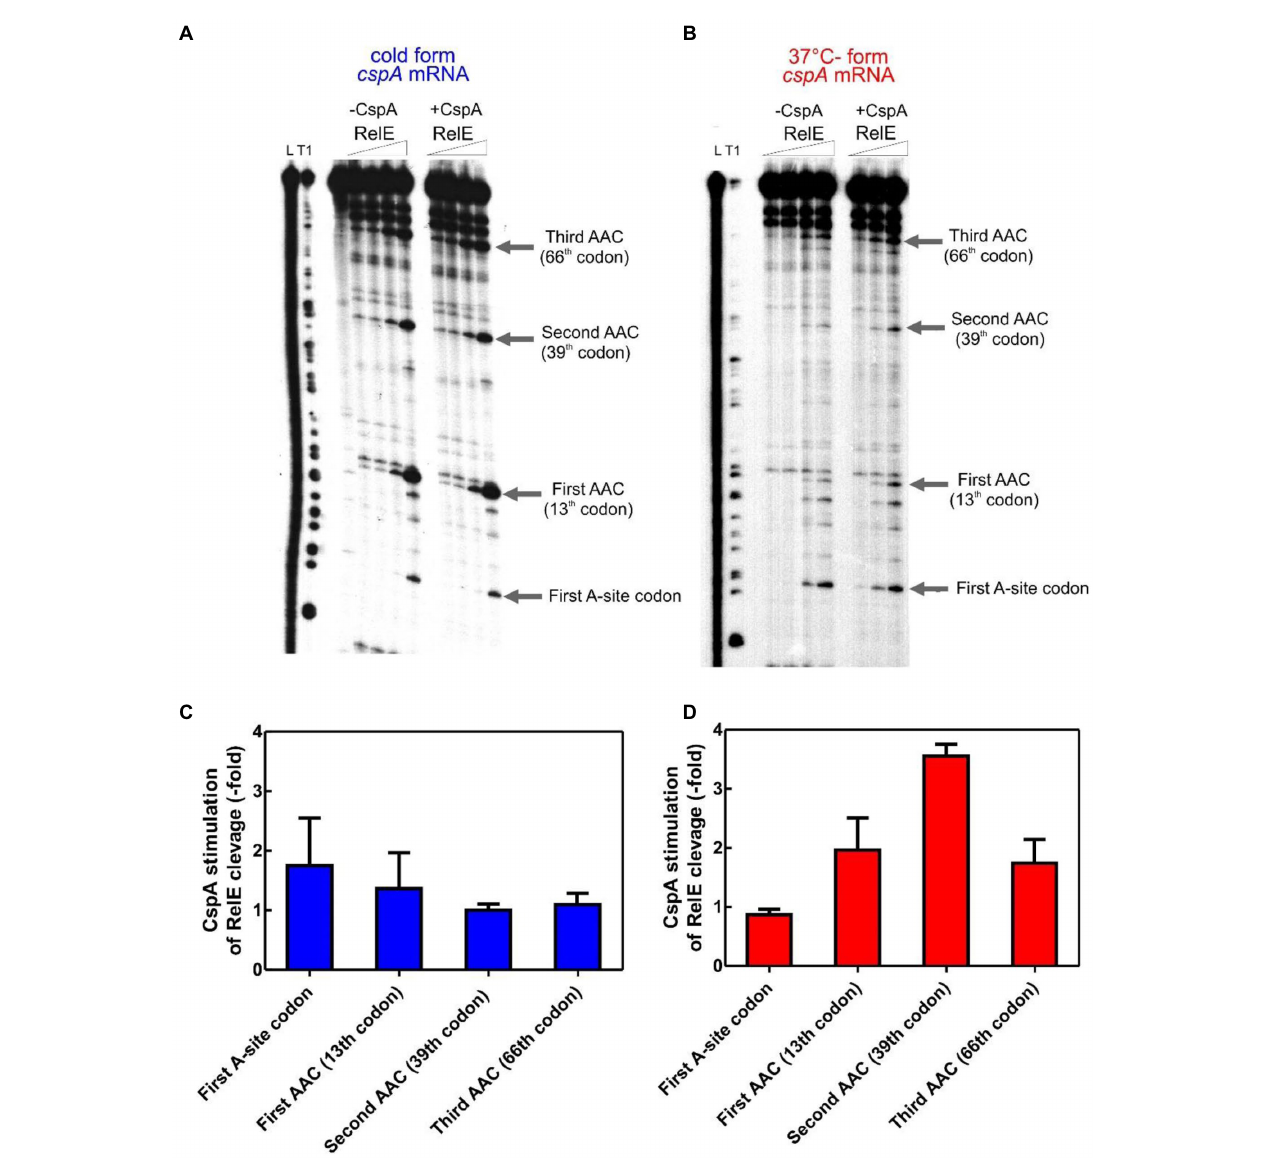
FIGURE 2 RelE walking experiment. 32 P-labelled cspA mRNA, folded in the cold-structure (A) or in the 37 ° C-structure (B) , was used as templates for an in vitro translation assay with the PURE system and then cleaved with 0, 0.16, 0.72, and 1.44 μ M of RelE. Lane L: alkaline ladder; lane T1: RNase T1 ladder. The first A-site codon (after the AUG initiation codon) and the AAC codons specifying Asn are indicated. Numbering is given according to the initiation codon. (C) and (D) show the effect of CspA (30 μ M) on the intensity of RelE cleavages (normalized to the total radioactivity present in each lane) on the 15 ° C- and 37 ° C-forms, respectively. The three different RelE concentrations were used to calculate the observed fold change and the associated statistical variance (standard